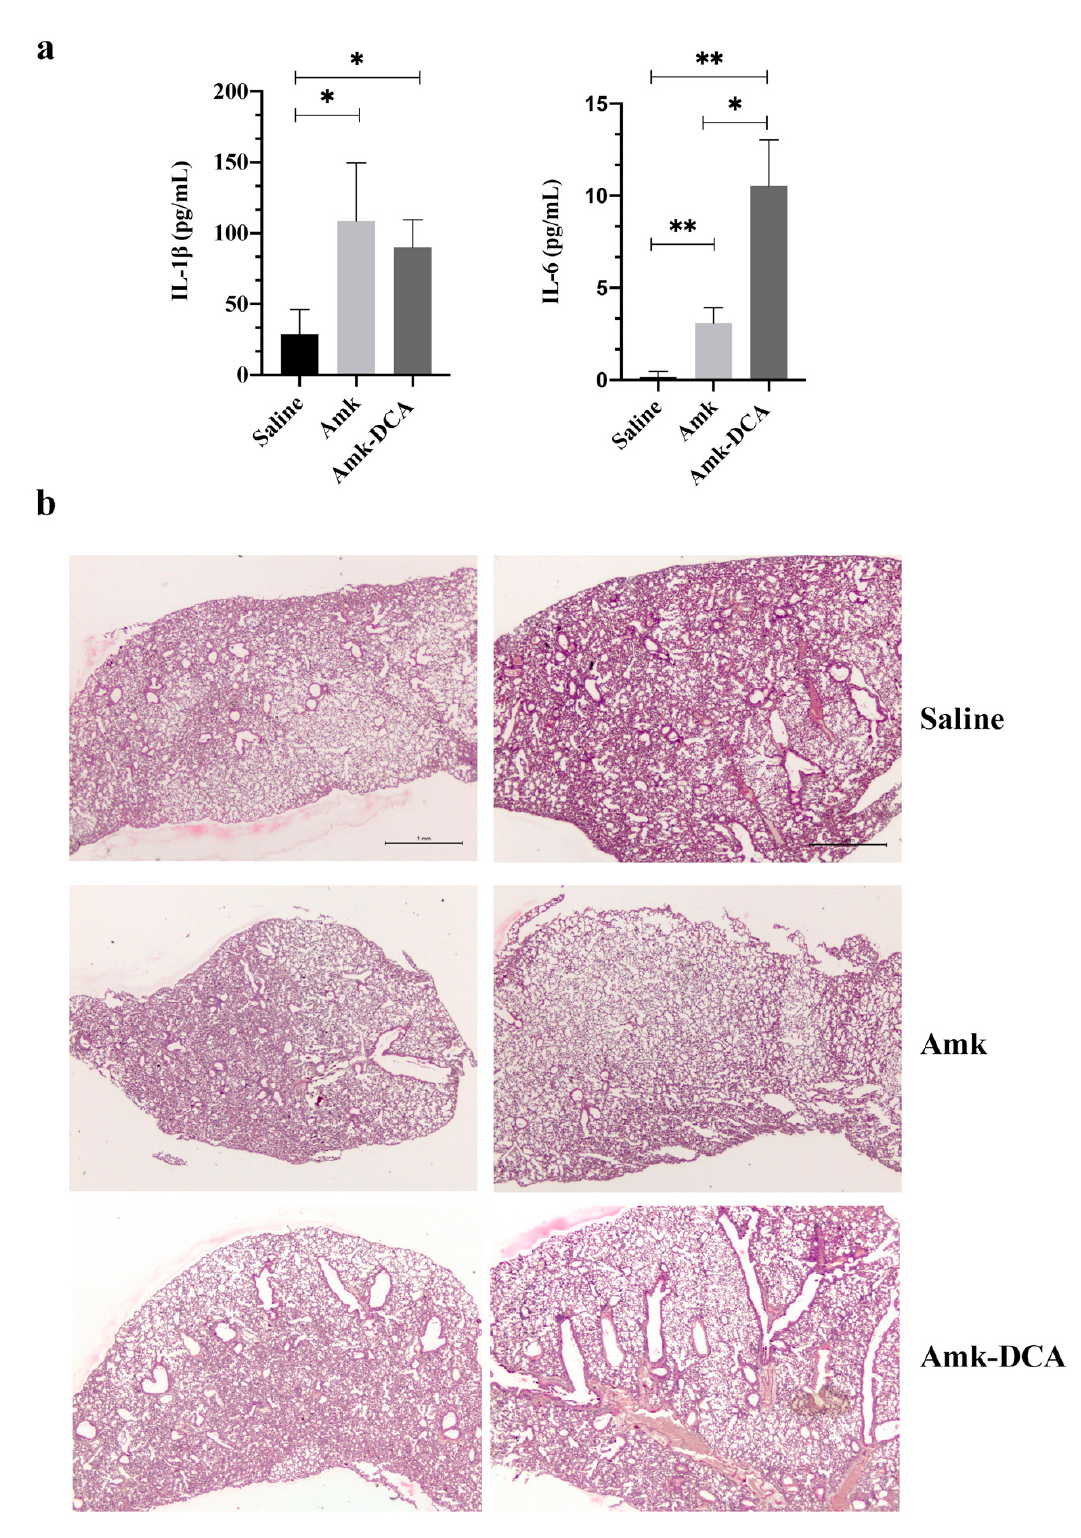
Figure 3. ( a ). Levels of proinflammatory cytokines IL-1 β and IL-6 in the lung homogenates after two repeated i.n. admin- istrations of the vehicle (saline), Amk solution and Amk-DCA suspension at 2 mg/kg dose (mean ± standard deviation, n = 3). ( b ). Histological assessment of mouse lung tissue after i.n. instillation with sterile saline (control mice), Amk and Amk-DCA (100 × magnification), * p ≤ 0.05, ** p ≤